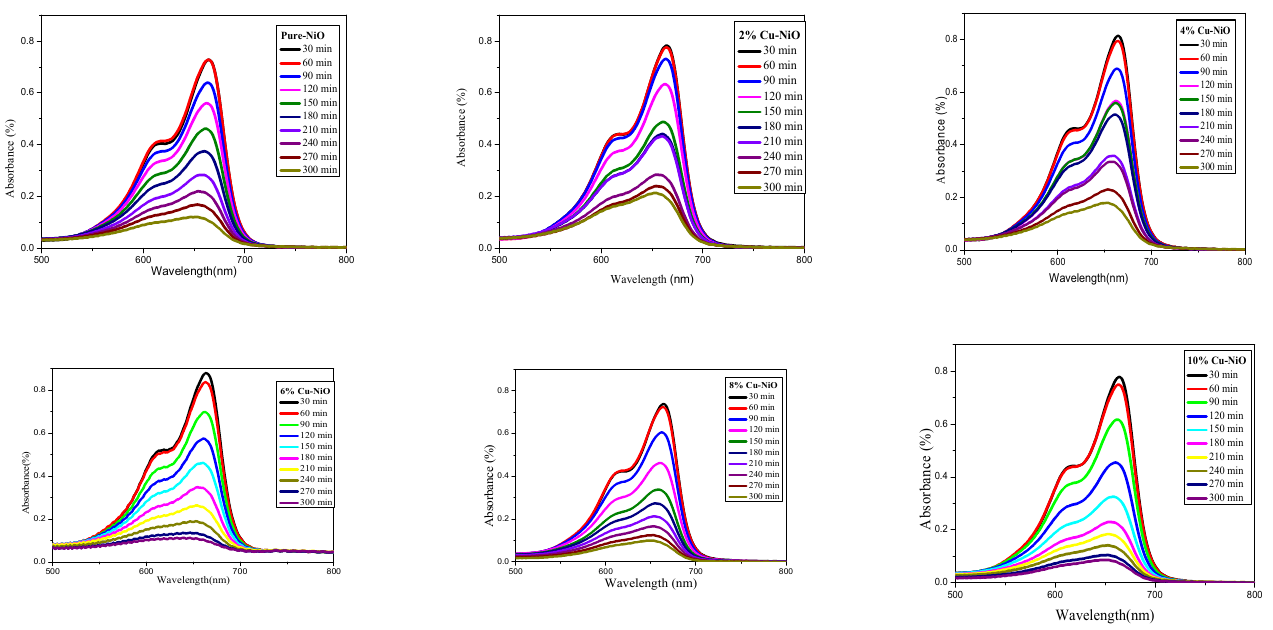
Figure 6. Effect of NiO nanoparticles on the decrease in Methylene Blue aqueous solution during UV irradiation.